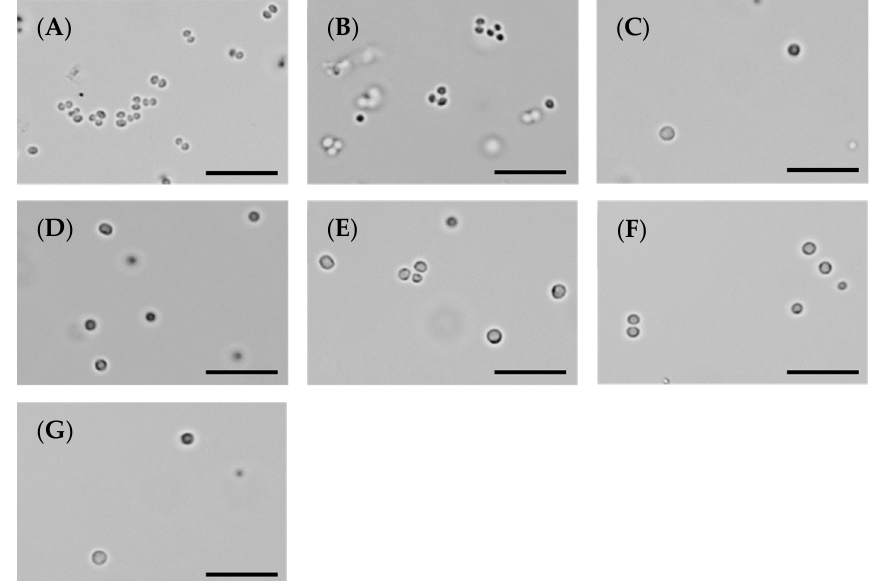
Figure 4. The MST compounds inhibit cell division in MRSA ATCC 43300. A culture of MRSA ATCC 43300 was adjusted to a density of approximately 1.5 × 10 8 CFU / mL in MH broth and incubated at 37 ◦ C. A 1 µ L aliquot was taken out at varying timepoints (0, 1, 3, 6 and 18 h) and imaged by light microscope at a magnification of 100 × . The images shown here were taken at 6 h post incubation with the MST compounds; a pre-bactericidal timepoint according to the kill kinetics from Figure 3. Images are ( A ) in the absence of the compounds, ( B ) with the divisome inhibitor, divin at 64 µ g / mL, or with the MST compounds at 2 × MIC values: ( C ) MST A9 ( 1 ) at 16 µ g / mL, ( D ) MST A12 ( 2 ) at 8 µ g / mL, ( E ) MST B8 ( 3 ) at 64 µ g / mL, ( F ) MST B9 ( 4 ) at 8 µ g / mL and ( G ) MST C4 ( 5 ) at 8 µ g / mL. Scale bar is 50 µ